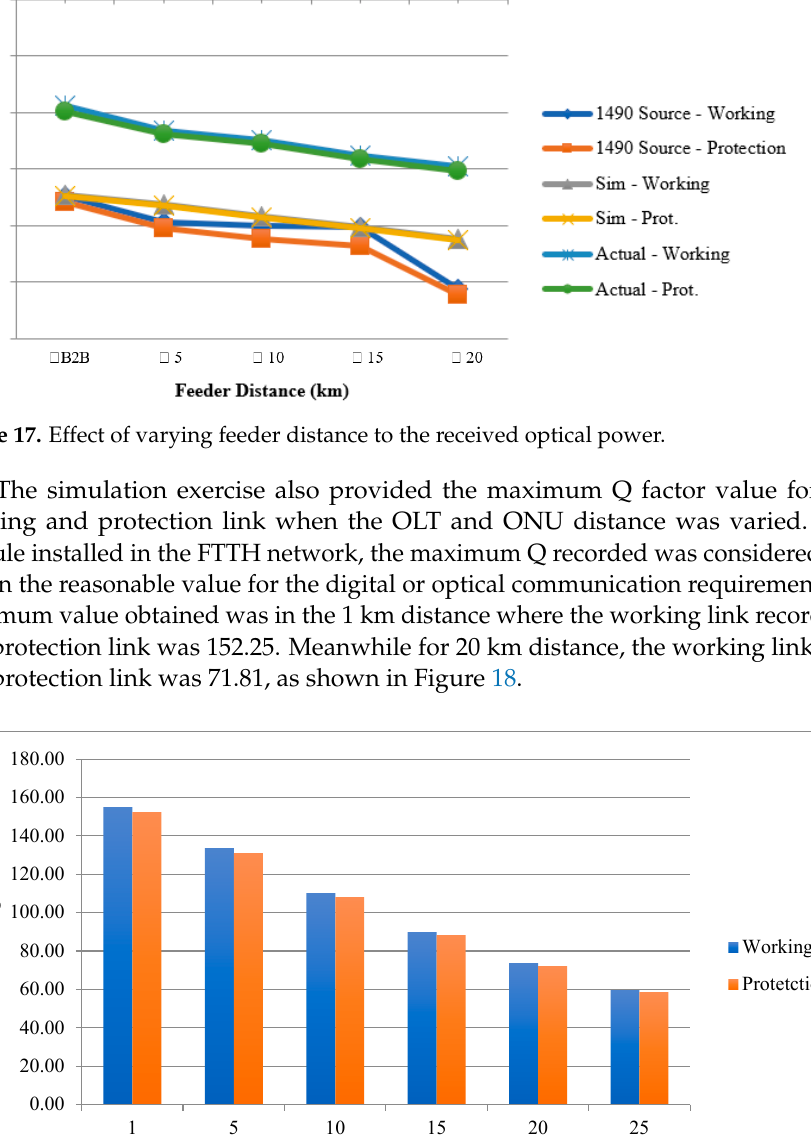
Figure 18. Maximum Q factor with varying feeder distance.